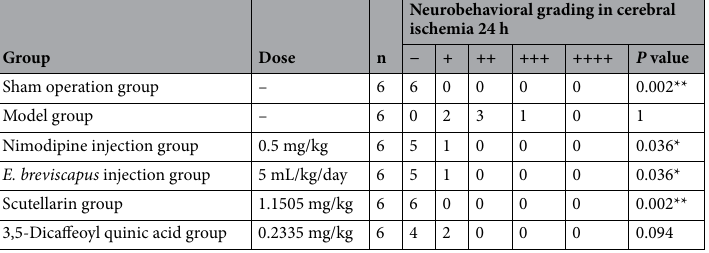
Table 2. Neurobehaviology of rats. *Compared with the model group, * P < 0.05 and ** P < 0.01.